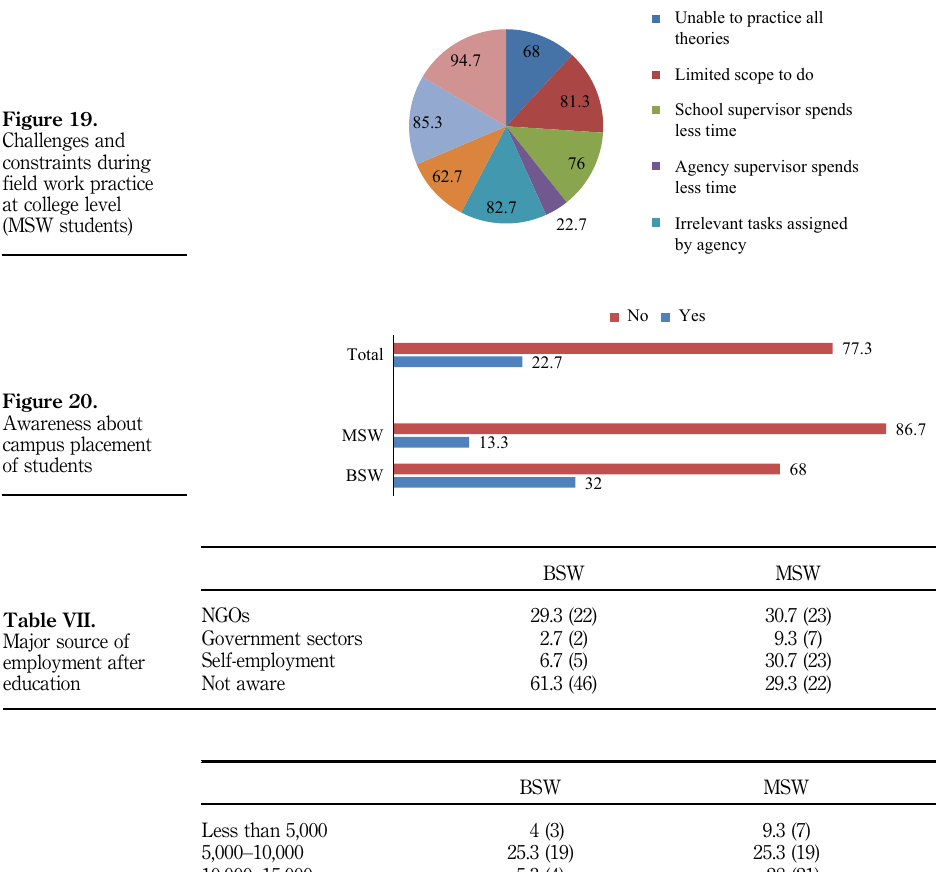
Figure 19. Challenges